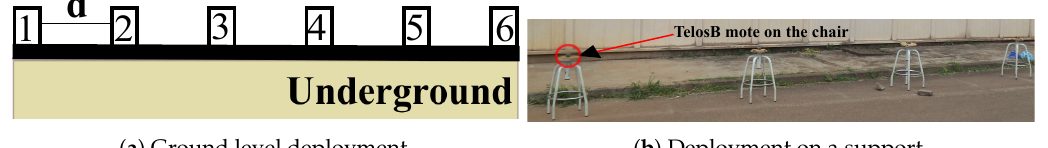
Figure 3. Sensors